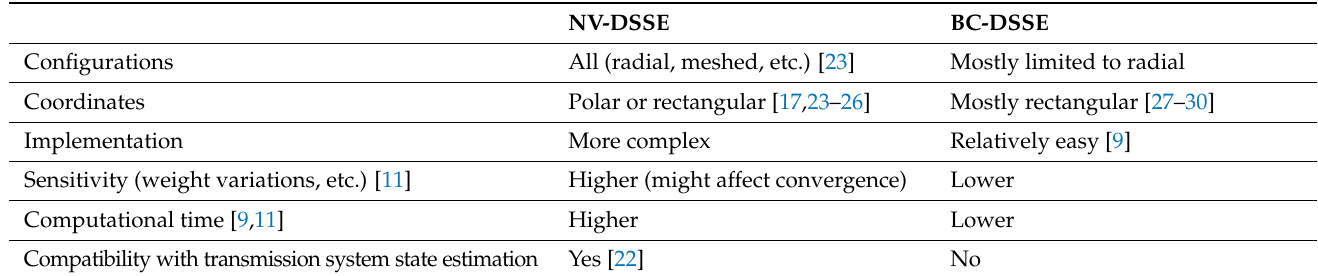
Table 1. Comparison between NV-DSSE and BC-DSSE